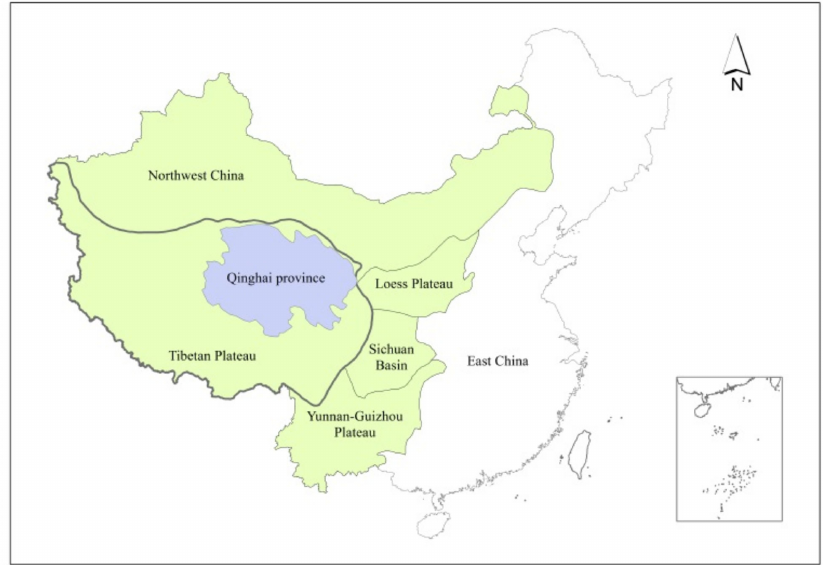
Figure 1. Division of western China and location of Qinghai province, China (The division of western China was based on Wang and Shen [17]).